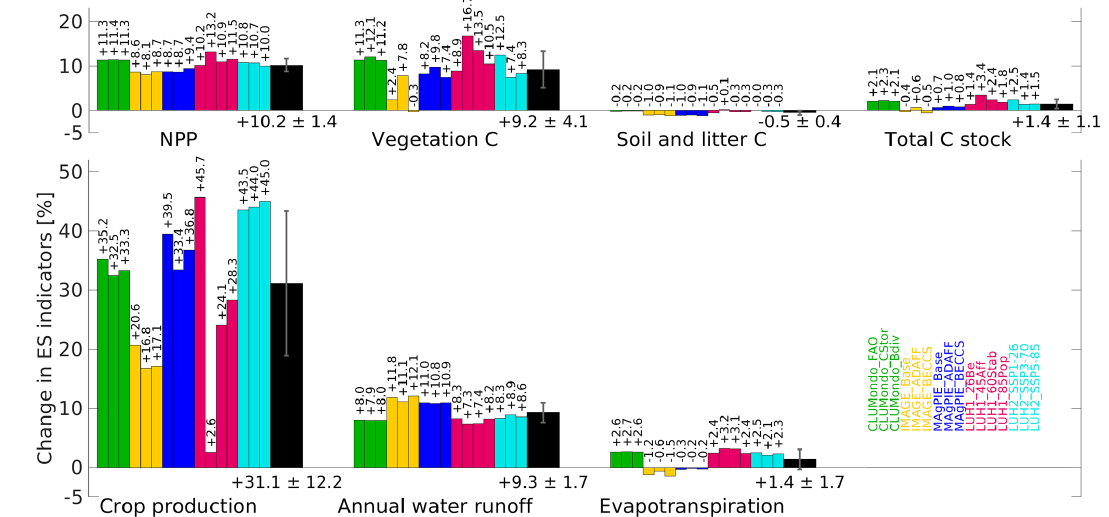
Figure 3. Change and uncertainty in ES indicators from 2000–2004 to 2036–2040 as a percentage relative to the base level in 2000–2004 across 16 land-use scenarios. Black bars give the average and standard deviation of the relative changes across all scenarios. See Table S3 for absolute levels and changes for each